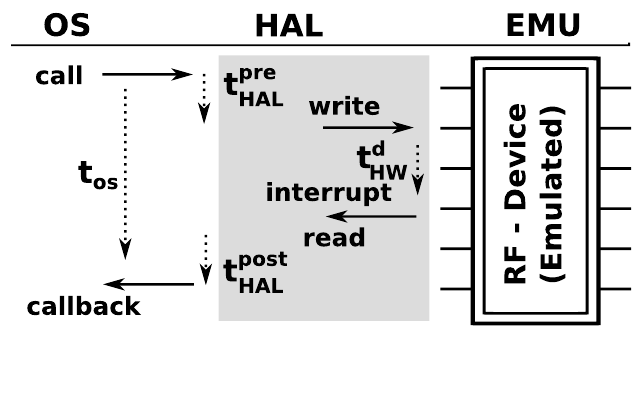
Figure 3. Call propagation between different abstraction levels and the emulated